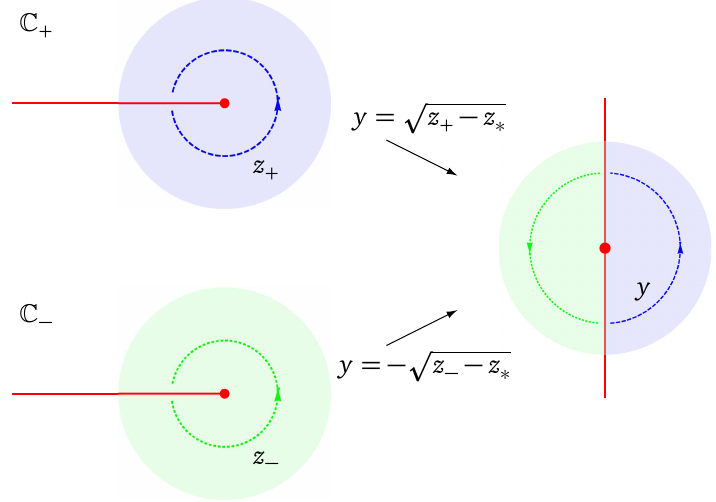
Figure 3: Neighbourhood of a point q = [ z ∗ , (cid:67) + ] = [ z ∗ , (cid:67) − ] in a Riemann surface (right) such that z ∗ is a branch point of the function g from which the Riemann 0 surface is built. The neighbourhood is formed by gluing together along the branch cut originating from q two half-disks obtained from taking the square root of full disks from the sheets (cid:67) ± (left). The complex numbers z ± parametrize half a neigh- bourhood of q in (cid:67) ± . The local parameter y at q is a complex number that fully parametrizes the neighbourhood of q